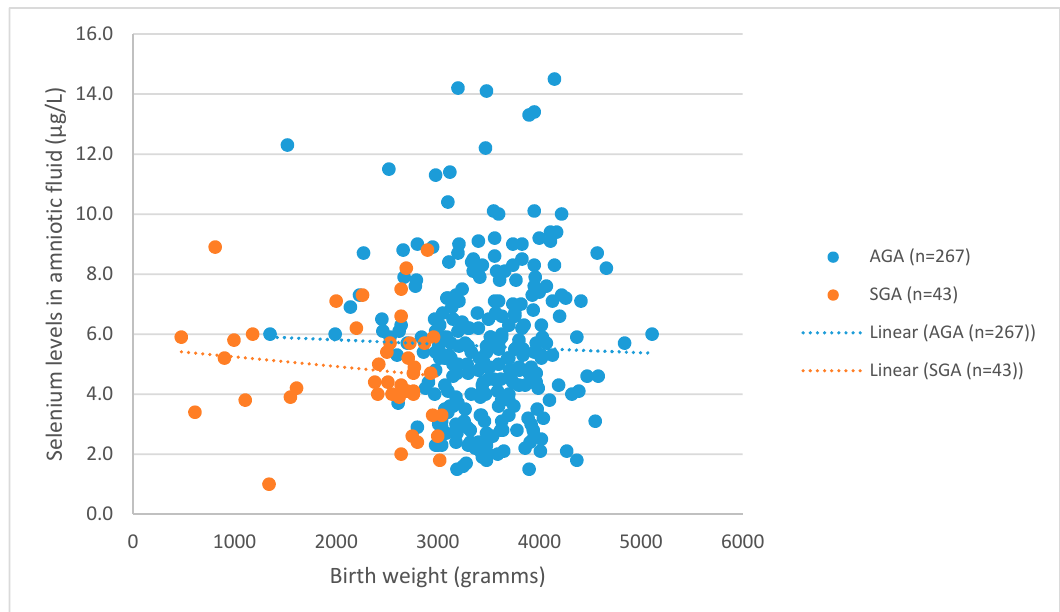
Figure 1. Distribution between Selenium levels and birth weight in small-for-gestational-age (SGA) and appropriate-for-gestational-age (AGA) newborns. A significant correlation was found between Se levels and SGA newborns ( t = 2.080, p = 0.038). Table 1. Obstetrical characteristics of pregnant women included in the